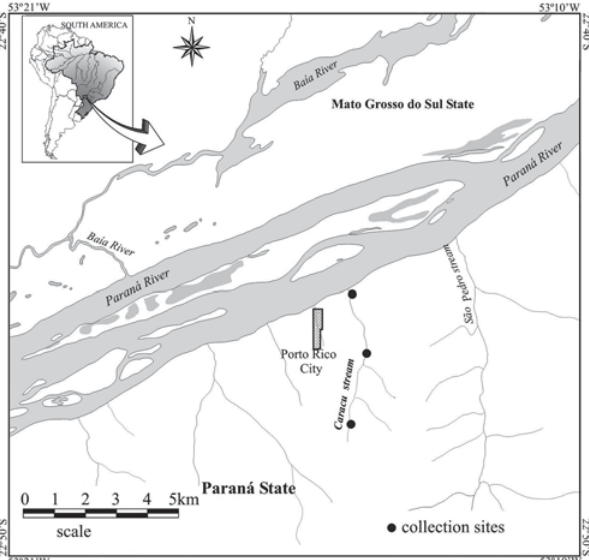
Fig. 1. Localization of Caracu stream where the Gymnotus specimens were